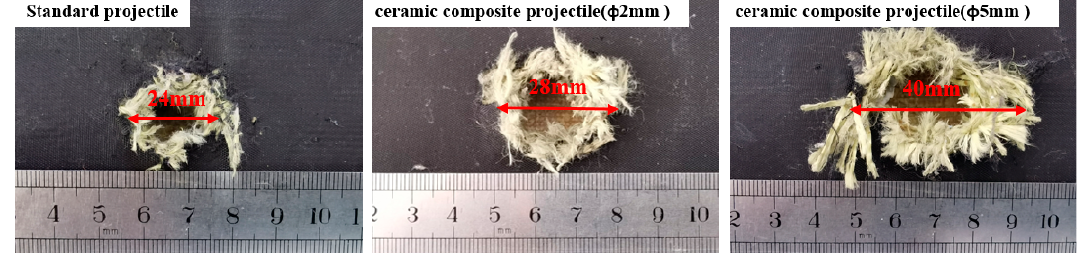
Figure 12. Damage caused to the Ceramic/Kevlar composite armor surface.